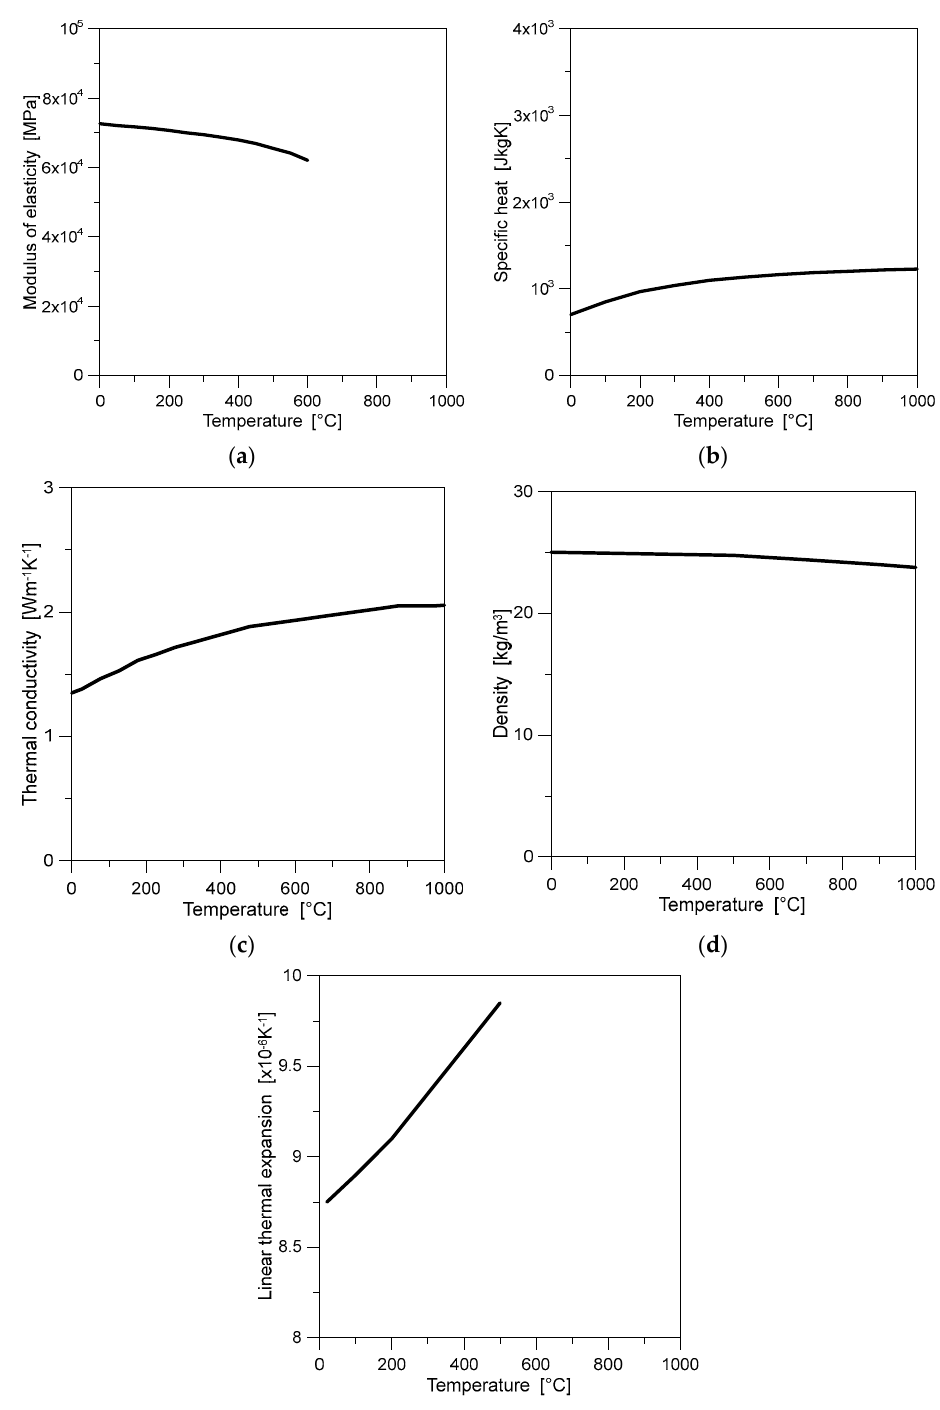
Figure 4. Selected glass material properties, with evidence of their sensitivity to temperature variations: ( a ) modulus of elasticity; ( b ) specific heat; ( c ) thermal conductivity; ( d ) density; ( e ) thermal expansion coefficient.